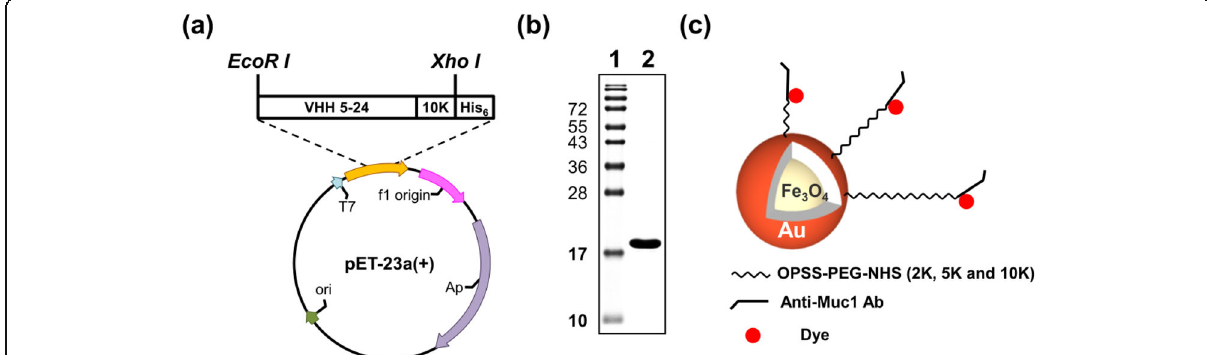
Fig. 2 Expression and purification of anti-Muc1-VHH 5-24 K10 fusion protein. The VHH 5-24 K10 gene was cloned in-frame to produce a pET-23a-